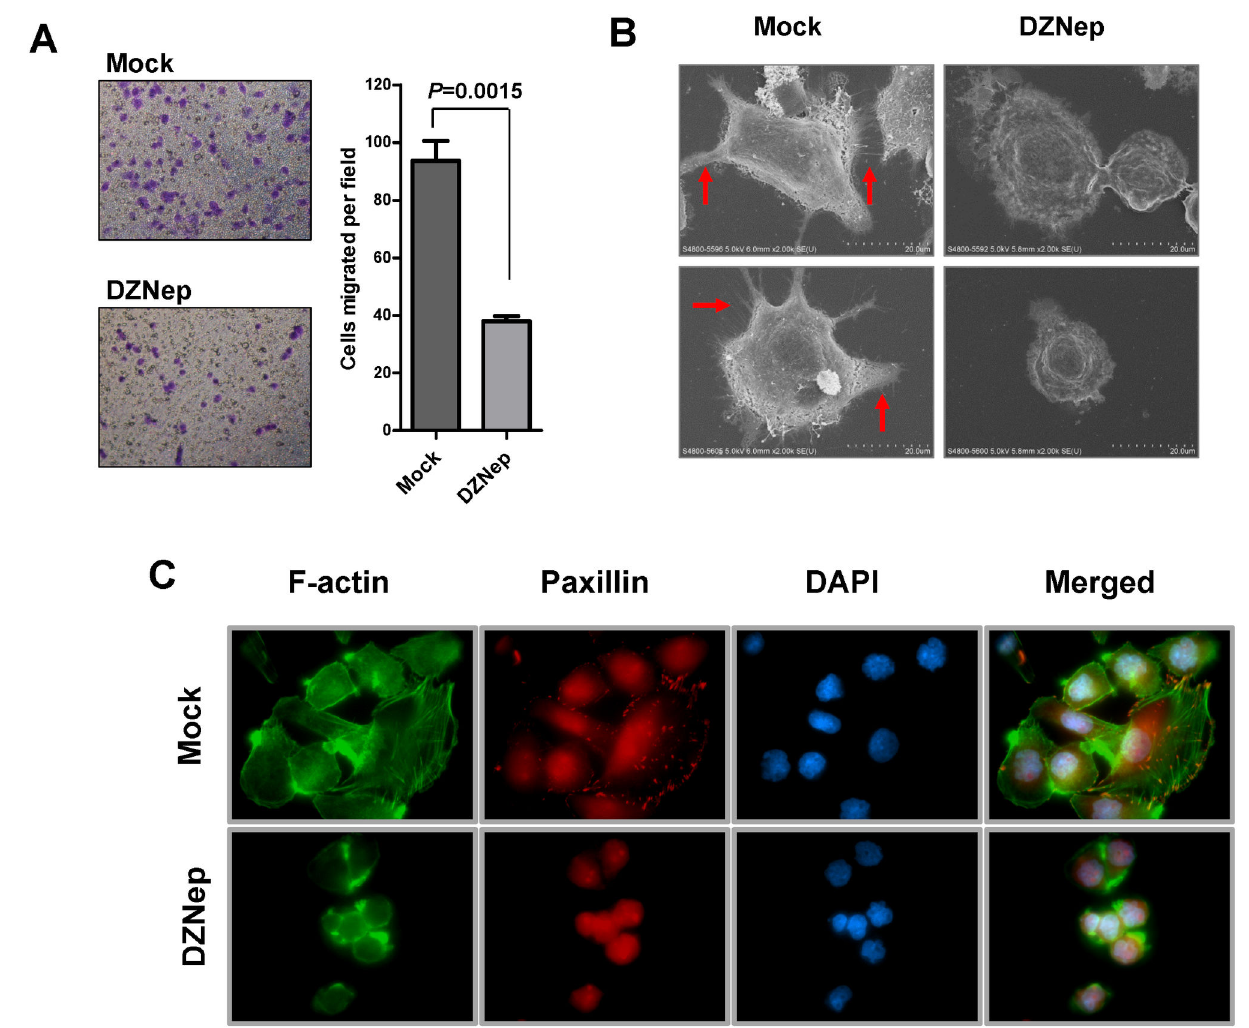
Figure 5. Treatment of DZNep inhibited HCC cell migration through disruption of actin cytoskeleton. ( A ) DZNep treatment effectively abolished MHCC97L cell migratory ability. Prior to cell migration assay, cells were treated with 1µM DZNep for 48 hours. Mock and DZNep-treated cells were then subject to cell migration assay using Transwell apparatus. Representative images of three independent experiments were shown. P -values obtained from t -test. ( B ) DZNep treatment suppressed formation of filopodia (red arrows) and lamellipodia (blue arrows) as illustrated by scanning electron microscopy. Images (2000x magnification) were captured using a Hitachi S-4800 FEG Scanning Electron Microscope. ( C ) DZNep treatment and focal adhesions were stained with anti-paxillin antibody. Nuclei were counterstained with DAPI. Mock-treated cells